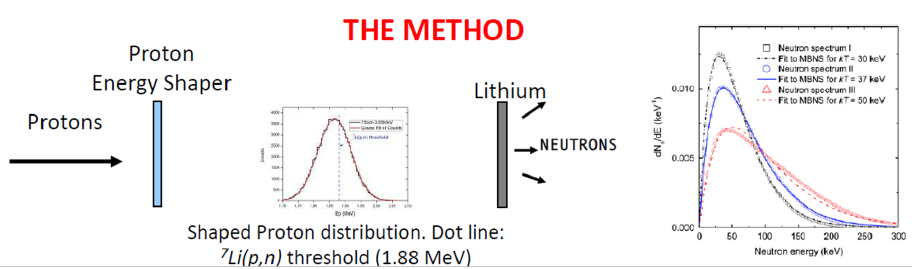
Figure 1. Method to produce a Maxwell-Boltzmann neutron spectrum (MBNS), proposed by Mastinu et al.